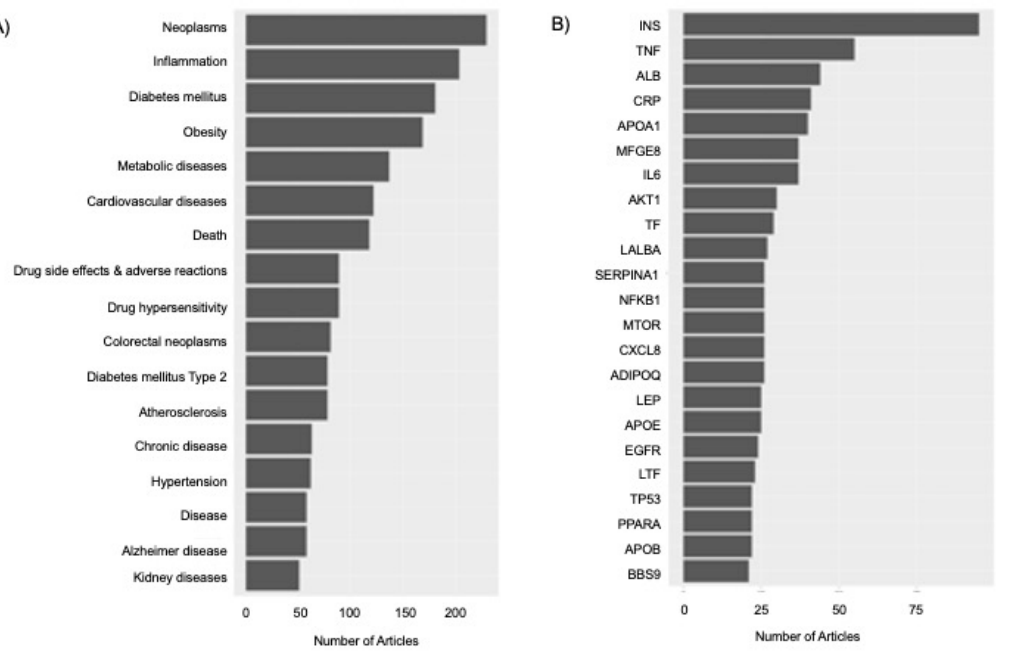
Figure 2. Document annotation of proteomic-nutrition corpus. ( A ) Diseases with 50 or more articles in the corpus. ( B ) Proteins with 20 or more articles. References for each disease or gene/protein can be obtained by clicking the bars in each interactive graph in supplementary File SA. The proteins